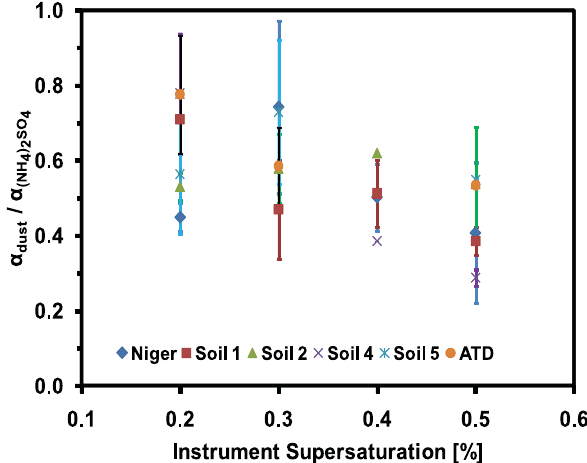
Fig. 10. Inferred water vapor uptake coefficients for the growth kinetics data of Fig. 8 normalized to that of (NH 4 ) 2 SO 4 calibration aerosol as a function of different instrument supersaturation. Error bars represent experimental uncertainty in determination of water vapor uptake coefficients arising due to differences in droplet sizes measured by the